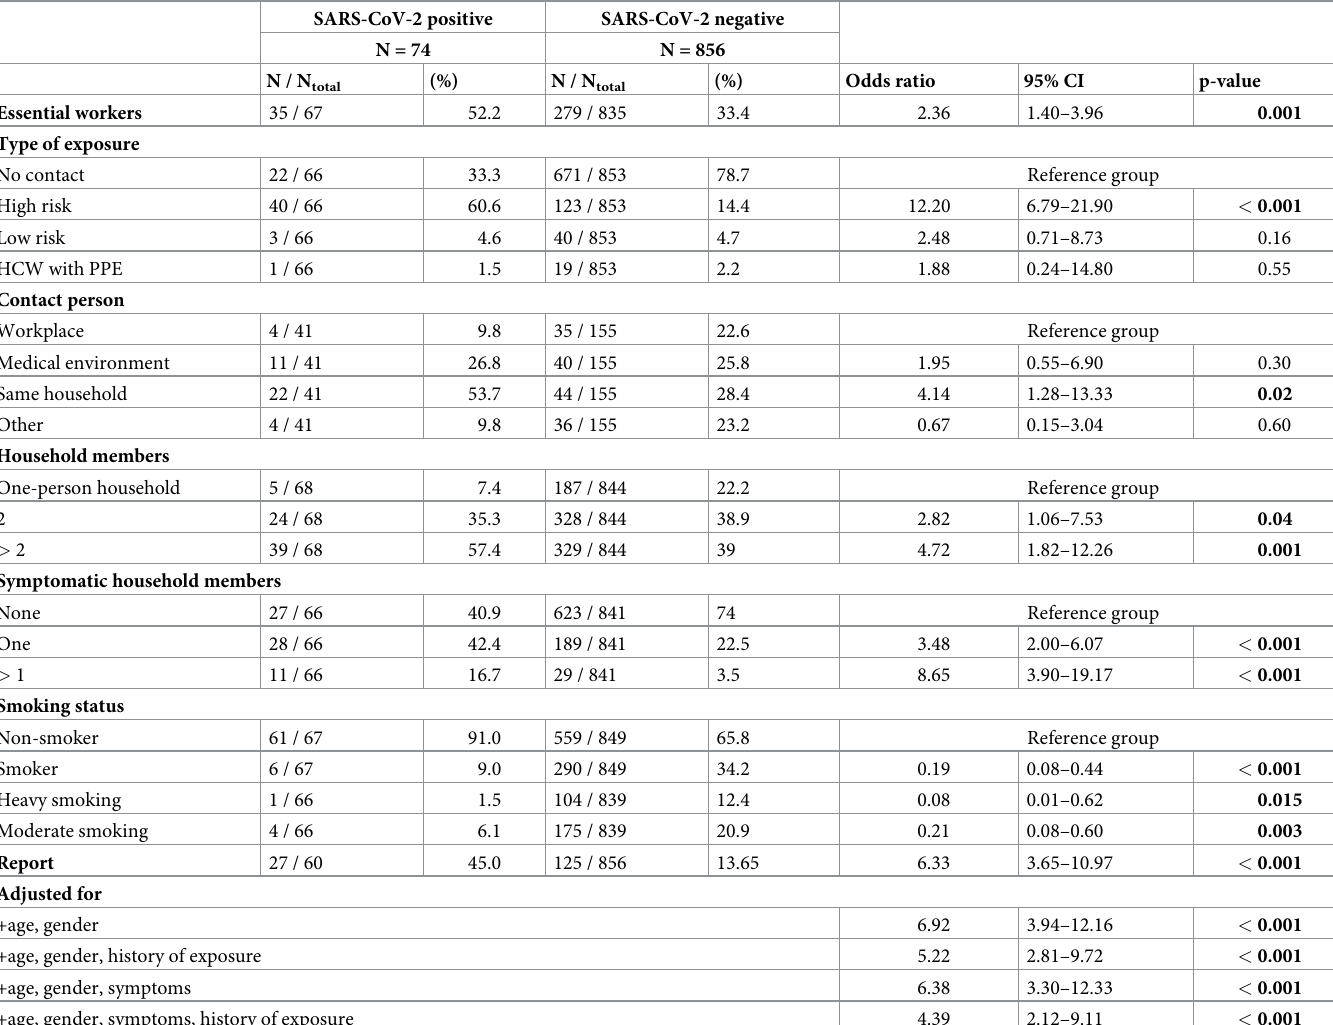
Table 2. Social risk factors for COVID-19 in an outpatient fever